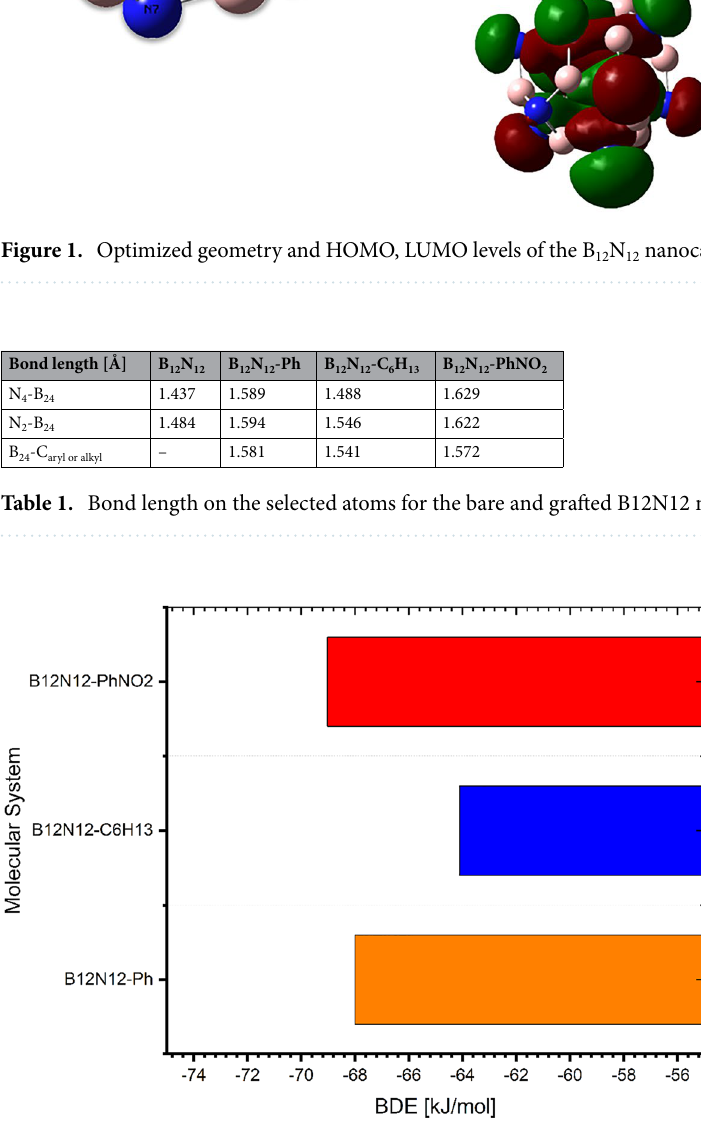
Figure 2. BDE values for the grafted B 12 N 12 nanocage cluster by corresponding aryl and alkyl